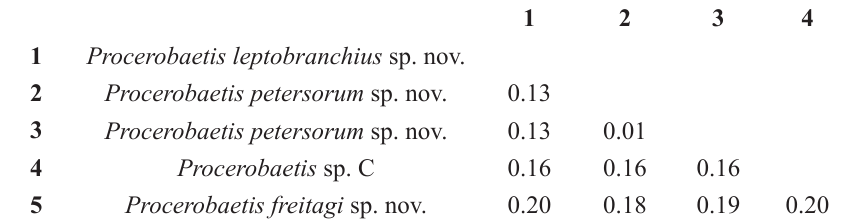
Table 4. Genetic distances (COI) between sequenced specimens, using the Kimura